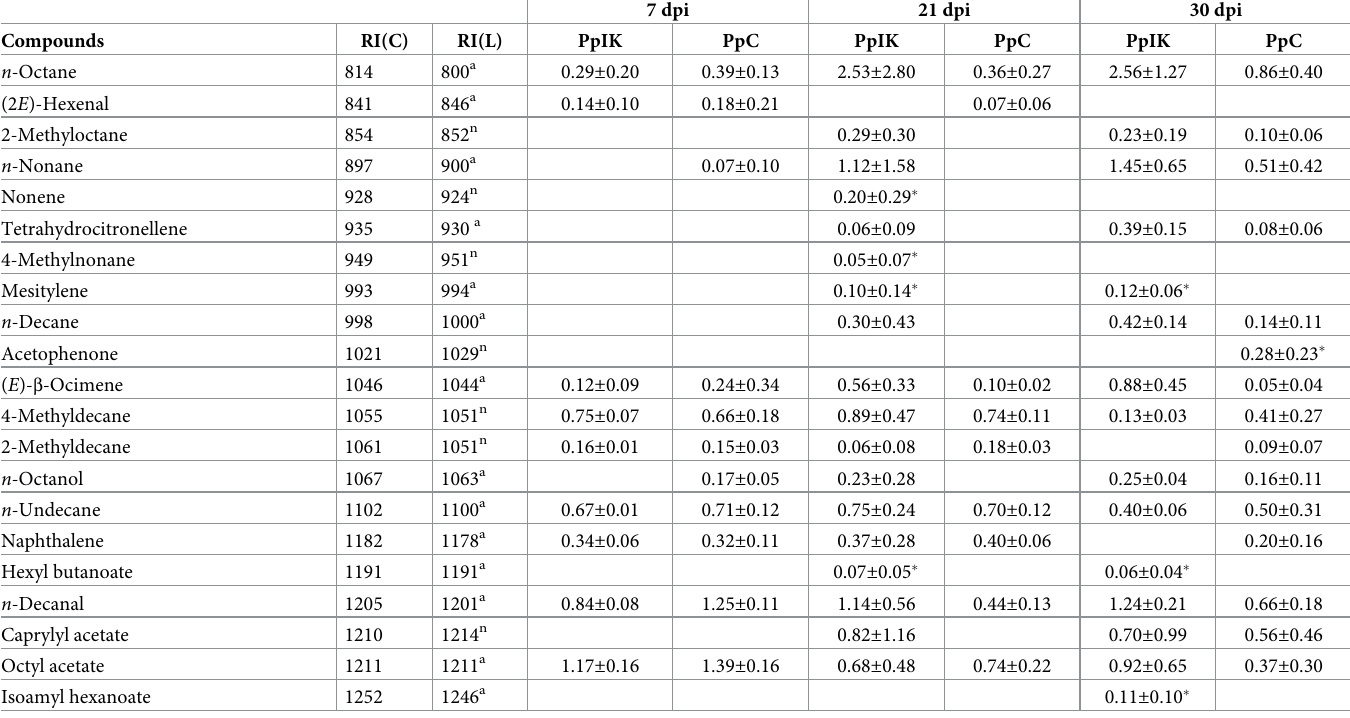
Table 4. Comparison of volatile compounds produced in leaves of Peperomia pellucida inoculated and non-inoculated with Klebsiella variicola